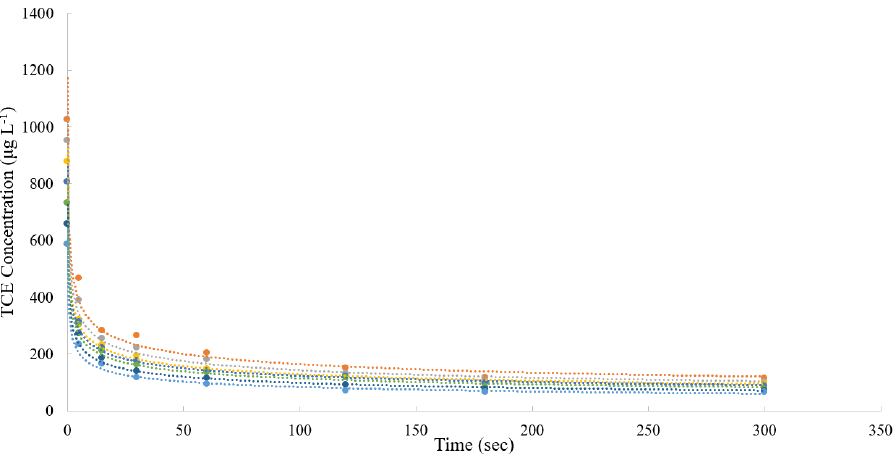
Figure 4. Adsorption experiment of different initial concentrations of TCE by activated carbon.